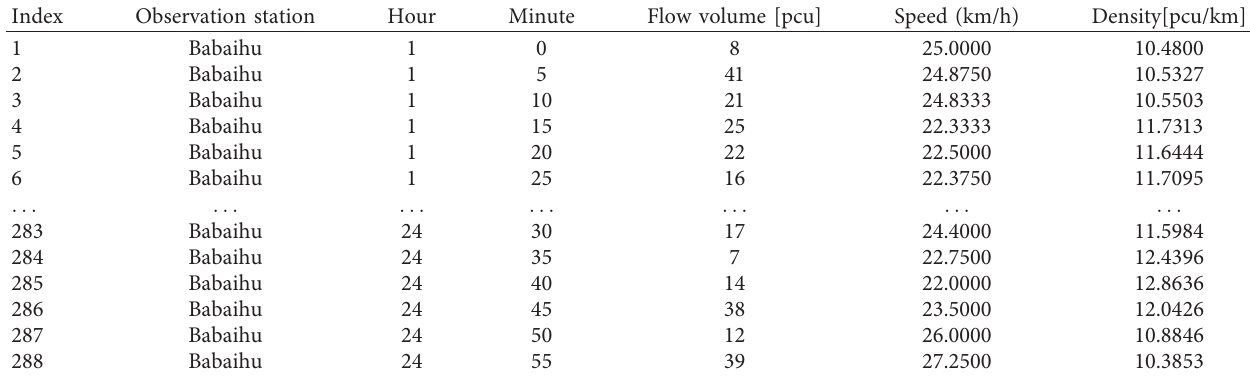
Table 2: Babaihu observation station data.